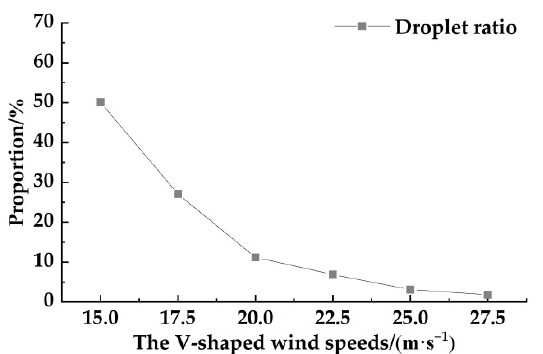
Figure 9. Proportion of drift droplets with different V-shaped wind speed.